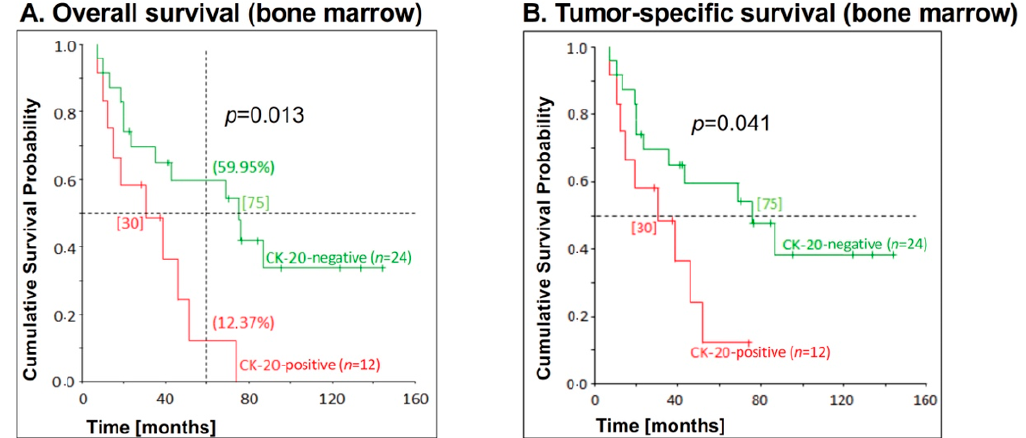
Figure 5. Correlation between CK20 positivity in bone marrow samples and survival for patients with esophageal carcinoma who had not received neo-adjuvant chemotherapy. CK20 positivity in bone marrow of EC patients who had not received neo-adjuvant chemotherapy ( n = 12) was assessed by RT-PCR and correlated with ( A ) overall survival and ( B ) tumor-specific survival. The p -values for the comparison of the cumulative survival probabilities of the two groups (CK20-positive versus CK20-negative) were calculated using the log-rank test. On the vertical dotted line at 60 months, the percentages of 5-year overall survival are shown in brackets. On the horizontal dotted line at the cumulative survival probability of 0.5 is the median survival and is given in months in square brackets.